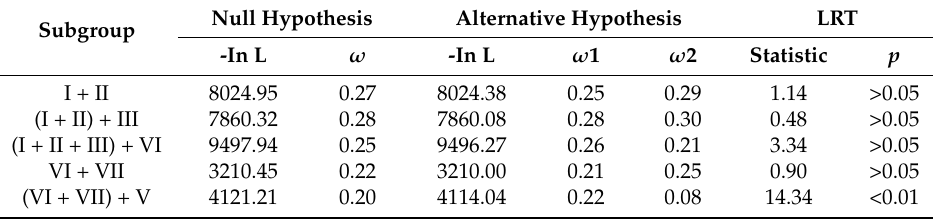
Table 2. Likelihood-ratio test (LRT) statistic and parameters from Branch model of PAML.